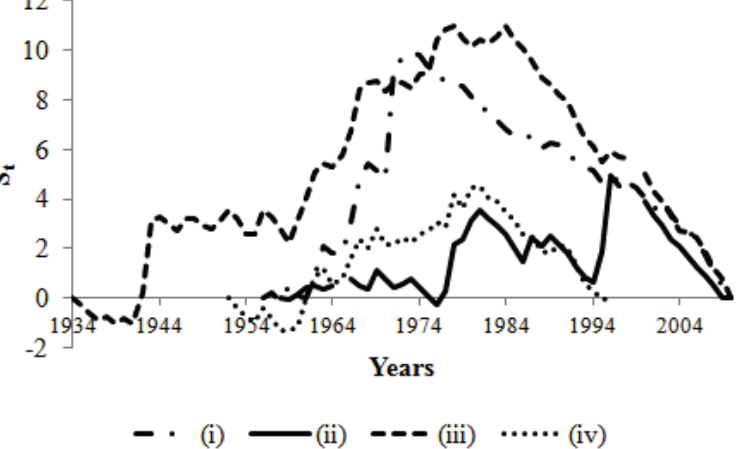
Fig. 3 SSF fluctuations in the Northern [(i), the Pengina River], Western [(ii), the Hayruzovo River], Eastern [(iii), the Avacha River], and Central [(iv), the Kirganik River] parts of the Kamchatka